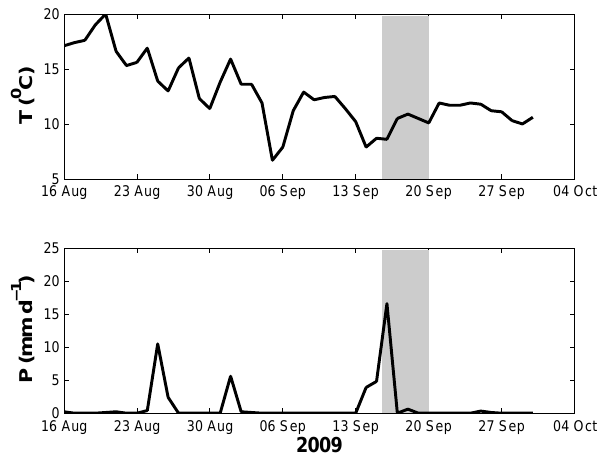
Fig. 18. Temperature and precipitation in summer 2009 at Zermatt, located approximately 15km west of the Feegletscher. The break- off events are indicated by a gray zone.